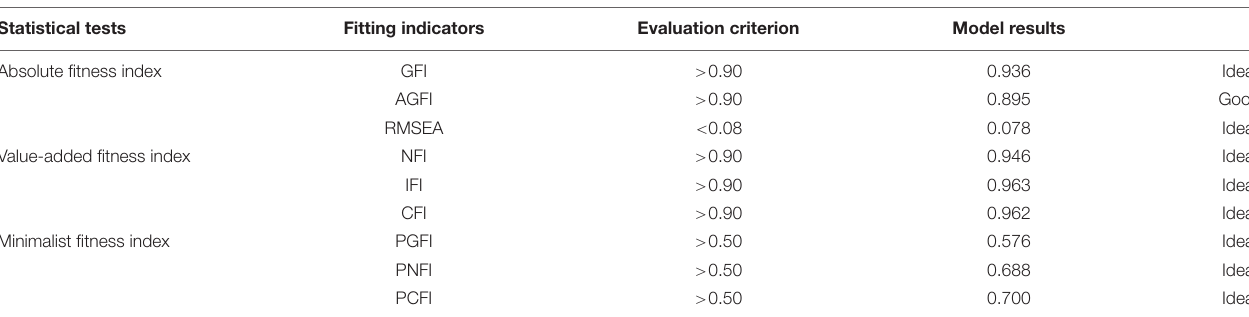
TABLE 8 | Model fitting index values.